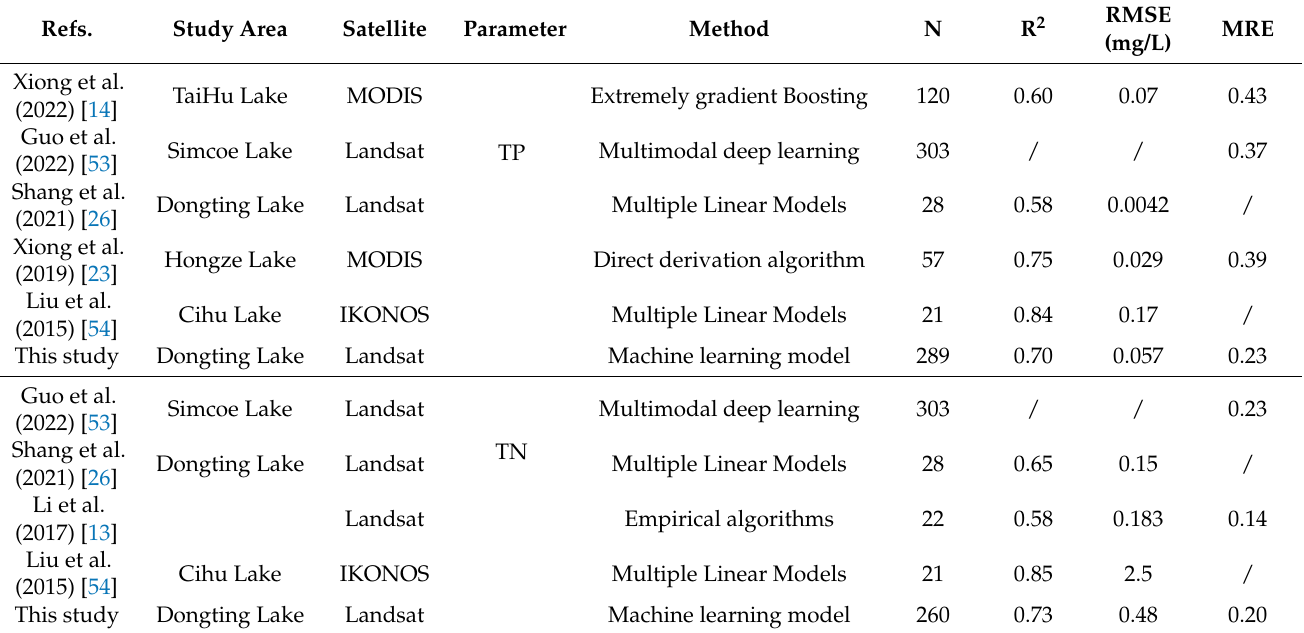
Table 4. Accuracy of TP and TN inversion models in other studies.